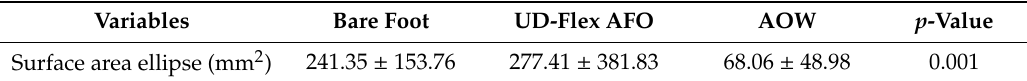
Table 3. Static balance using BioRescue.